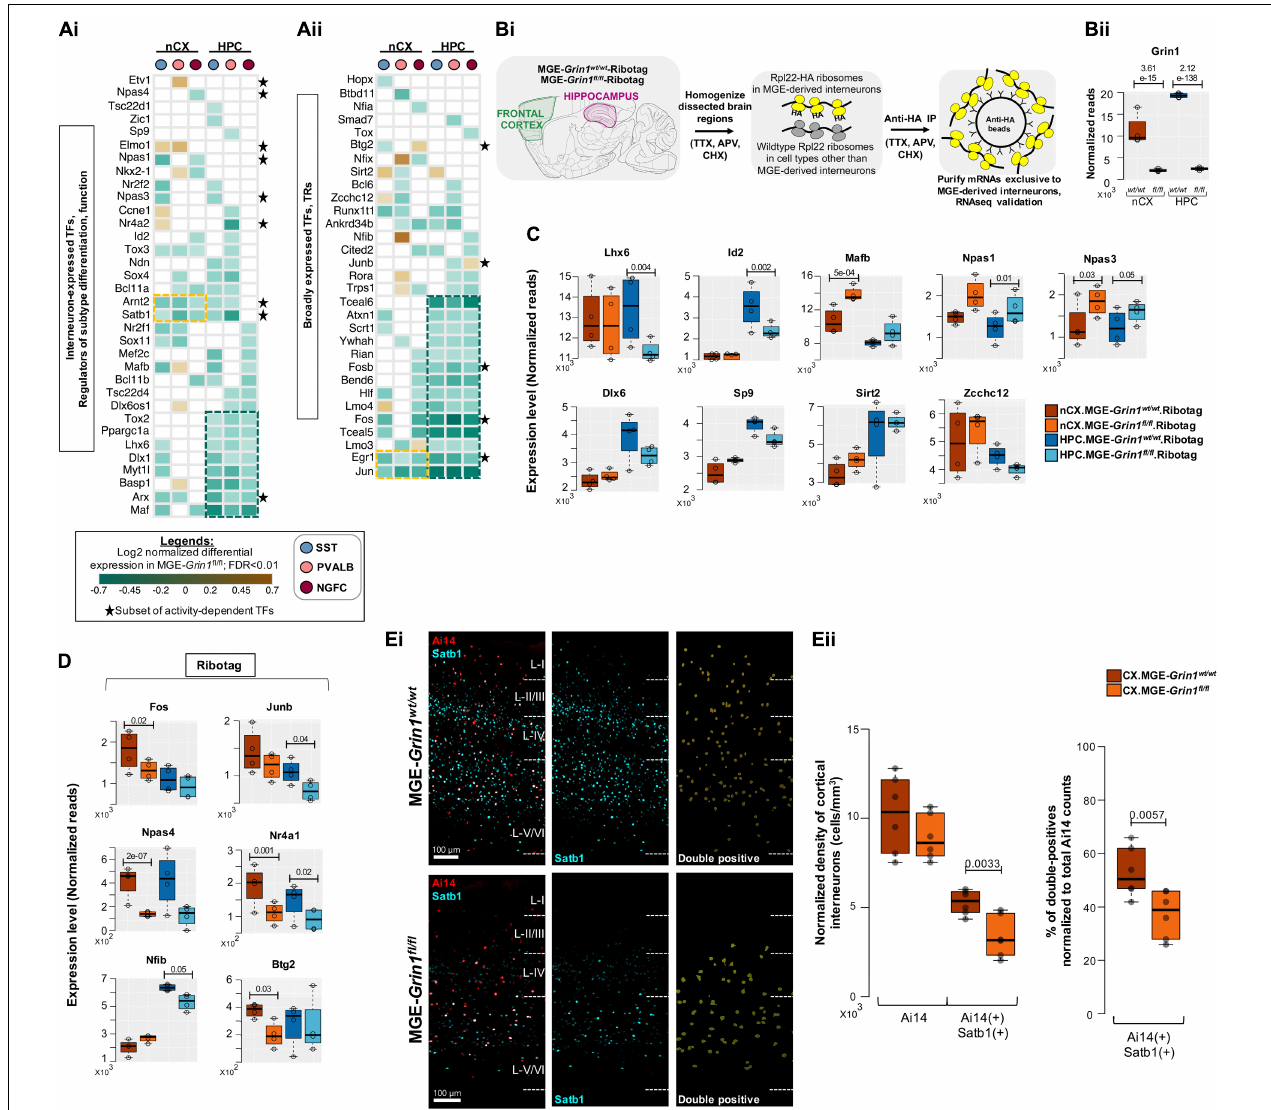
FIGURE 6 | NMDAR signaling in MGE-derived interneurons are highly dedicated to the transcriptional control of interneuron identity. (A) Heatmap of log2 FC of significant DEGs in neocortical and hippocampal MGE cardinal subtypes, showing a subset of (Ai) , Transcription factors (TFs) that are previously established to regulate MGE subtype identity and function; (Aii) , broadly expressed TFs and transcriptional regulators (TRs) that are not currently known to regulate MGE function. Clusters of commonly differentially expressed genes in neocortex and hippocampus are indicated in yellow or green boxes. * indicates a subset of neuronal activity-regulated TFs. (Bi) Overview of the experimental workflow for RNAseq validation, by ribosomal tagging/Ribotag strategy specific to MGE-derived interneurons. n = 4 biological replicates from each genotype for MGE-Ribotag-seq; Error bars reflect SEM; DeSeq2 for statistical analysis. (Bii) MGE-Ribotag-seq normalized reads for Grin1 expression in neocortex and hippocampus. MGE-Ribotag-seq normalized reads cross-validating the differential expressions of (C) , MGE-enriched TFs, and (D) , neuronal activity-regulated TFs. (Ei) Representative immunostaining of P25-30 somatosensory cortex using anti-Satb1 (cyan), and endogenous Ai14 reporter expression. Ai14:Satb1 double-positive cells are represented as yellow surfaces using Imaris9.6. (Eii) Boxplots indicate the normalized density of cortical Ai14(+) and Ai14(+): Satb1(+) double-positive cell counts. n = 3 brains from each genotype for immunostaining; Error bars reflect SEM from individual sections; two-tailed unpaired t -test, for statistical